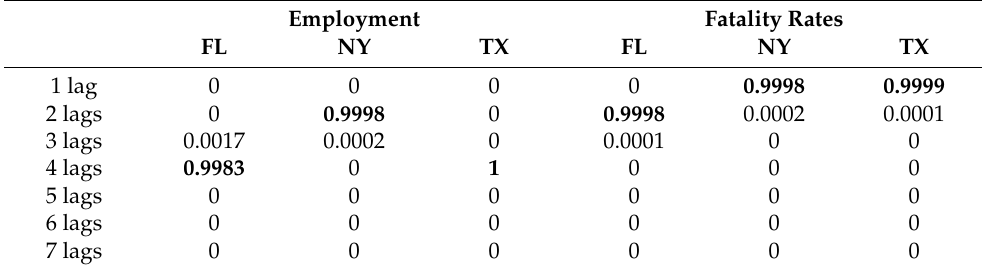
Table 1. Posterior probabilities of models with different number of